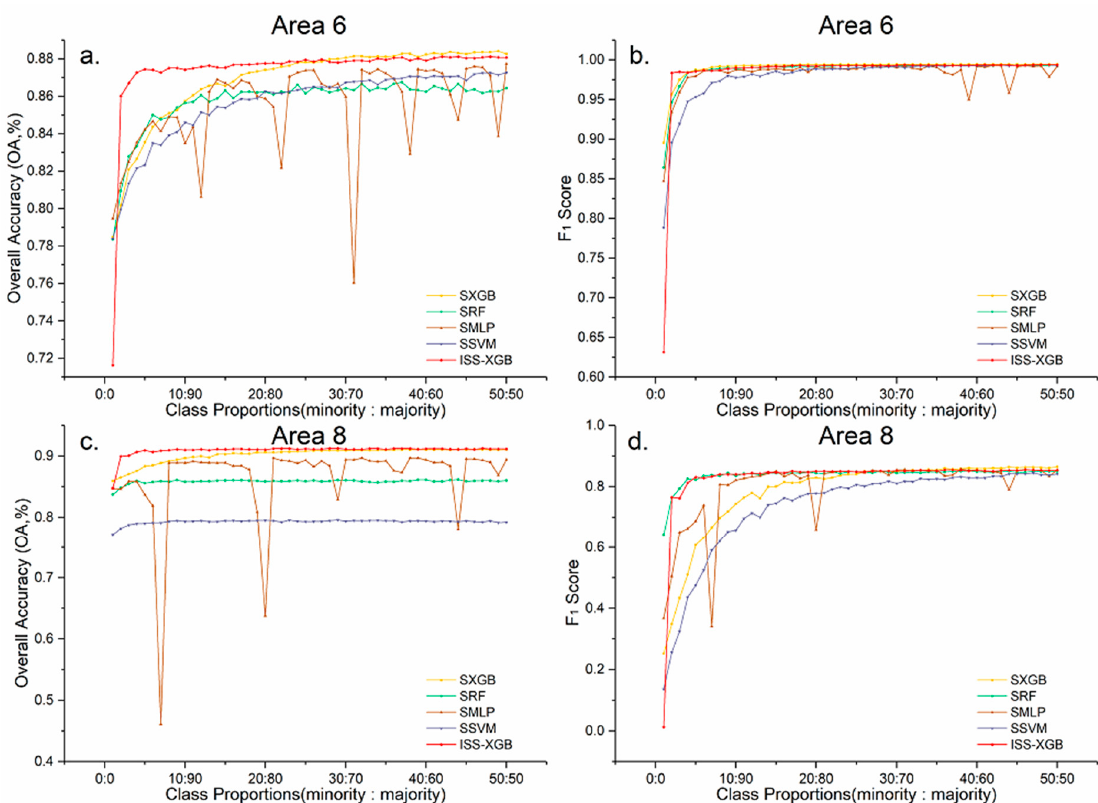
Figure 10. OA and F 1 score curves for the minority classes in Areas 6 and 8 across different imbalanced samples with ISS-XGB (red), SXGB (yellow), SRF (green), SMLP (brown), and SSVM (purple). Sub-figure ( a , b ) are the accuracy curves for Area 6 (( a ): OA; ( b ): F 1 score). Sub-figure ( c , d ) are the accuracy curves for Area 8 (( c ): OA; ( d ): F 1 score).